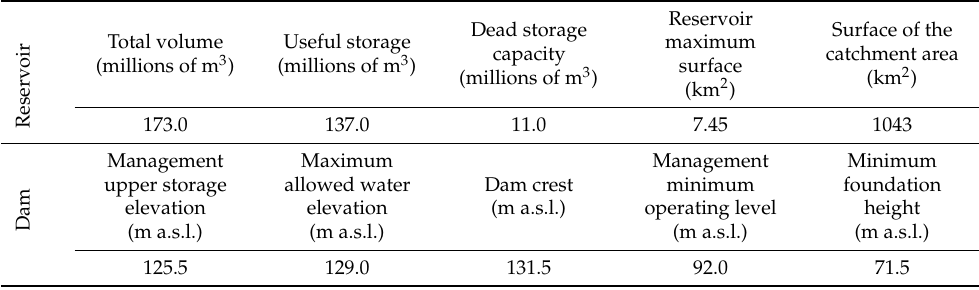
Figure 2. Surface spillway: ( a ) top view of the spillway; ( b ) ungated ogee weir (free Creager-type sill); and ( c ) gated weir with three 13 m wide openings, equipped with automatic flap gates. Table 1. Important features of the reservoir (Lake Guardialfiera) and the Liscione dam.